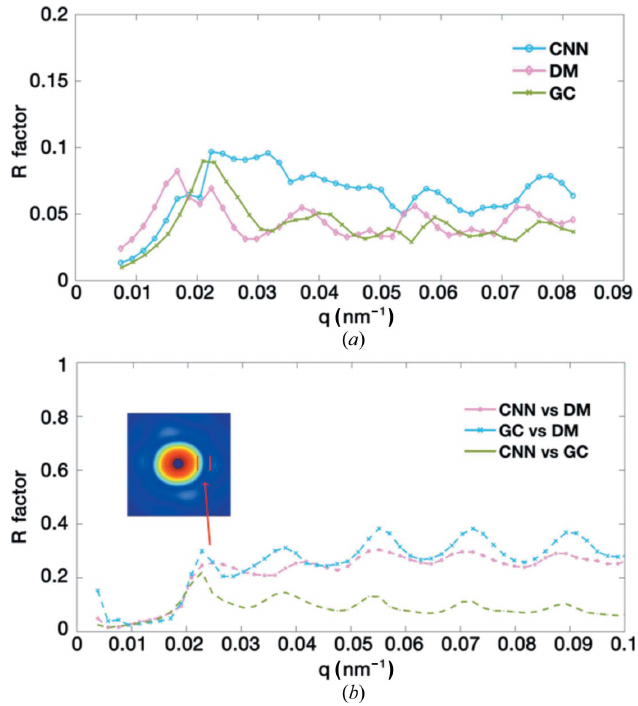
Figure 4 Self-consistency and cross-comparison of the merged results from the three datasets. Here q is calculated in the same way as in Fig. 3. The two graphs are ( a ) the R factors between the independent merged results from the same dataset and ( b ) the R factors for the merged results from the different